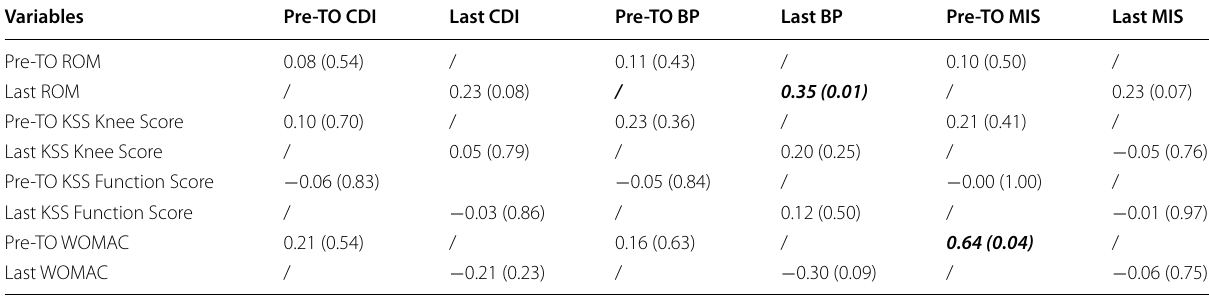
Data are presented as Spearman correlation coefficient ( p value) Significant correlations are displayed in bold and